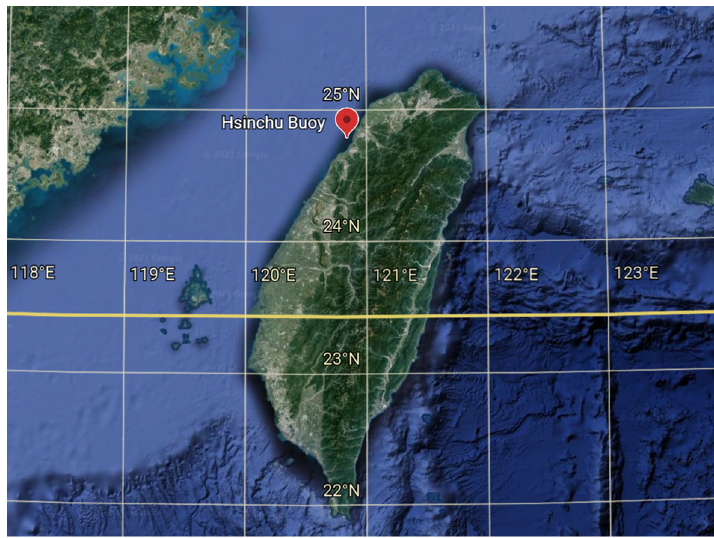
Figure 5. Location of the Hsinchu data buoy